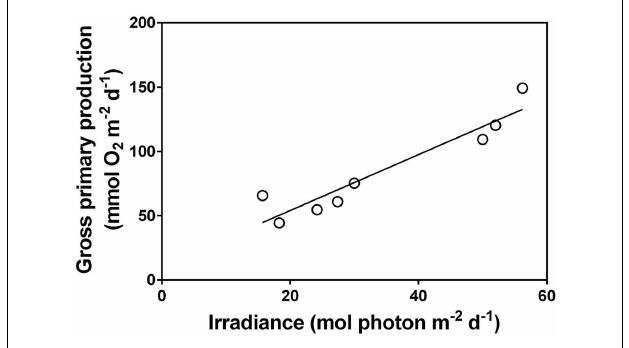
FIGURE 4 | Relationship between daily surface irradiance and community gross primary production in a shallow pond in Öland, Sweden over a daily time course of 8days with naturally variable light conditions (each data point represents 1day) .The dominant submerged aquatic plant in the pond was, Chara virgata (data extracted from Christensen et al., 2013). Pearson correlation = 0.96, P <